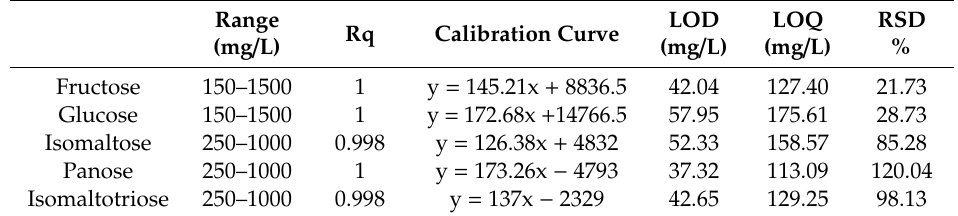
Table 4. Evaluation of the linearity range, correlation factor, calibration curves, LOD, LOQ, and precision (expressed as relative standard deviation, RSD%) of the analyzed standards by